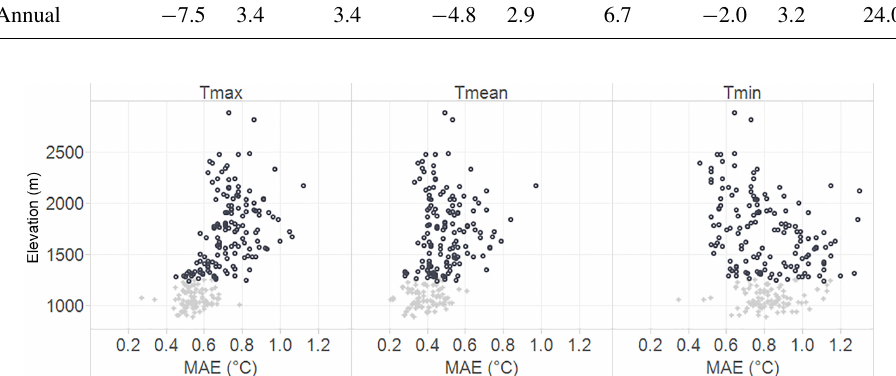
Figure 3. Estimated gap-filling errors shown as mean absolute error (MAE) for each site as a function of elevation. Errors are calculated as the differences between the actual temperature and the temperature estimated from the most closely correlated station.